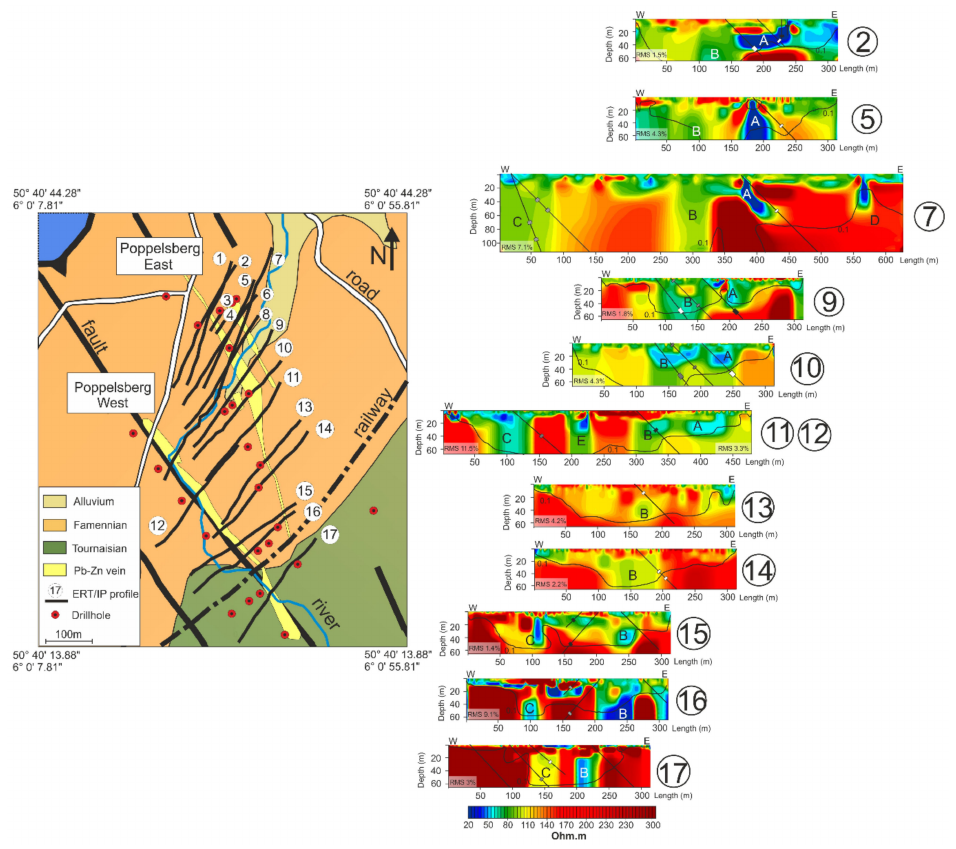
Figure 6. Resistivity results showing DOI 0.1 isolines and drillholes. The rectangles on the drillings represent mineralized area. Colour of these rectangles indicate the distance to the drillholes from the tomographic section, as follows: white rectangles: <10 m; grey rectangles: between 10 m to 20 m; and dark rectangles >20 m. A, B, C, D and E correspond to the anomalies which could be attributed to Pb–Zn mineralization (geological map modified from Laloux et al. [30]). Profiles 11 and 12 were combined in one single profile by